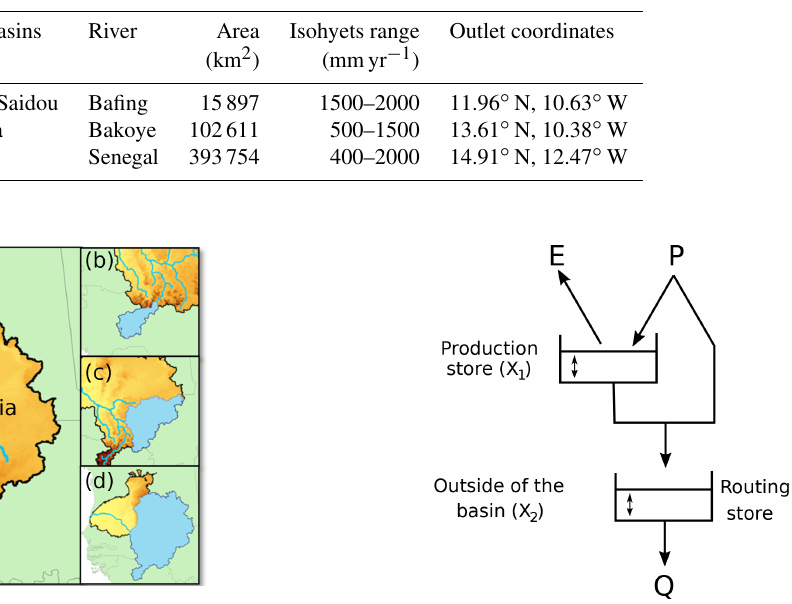
Figure 3. The SRB and its sub-basin boundaries. Red crosses rep- resent sub-basin outlets (a) , while sub-basin superficies are shaded in blue ( b , Daka Saidou; c , Oualia; d , Bakel).